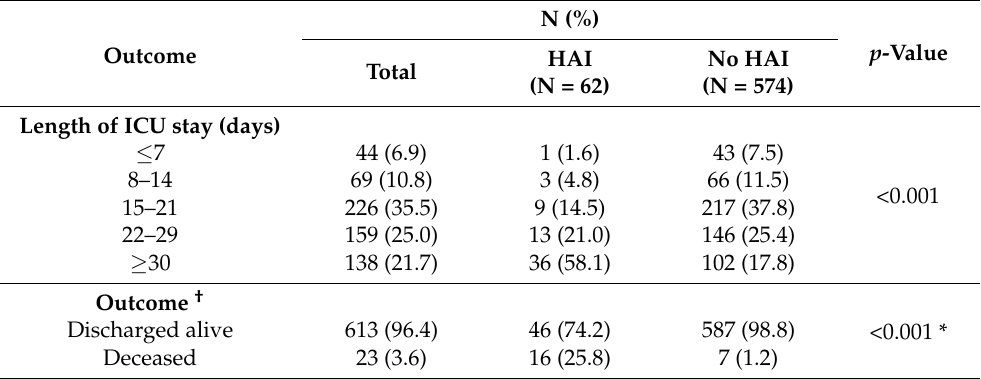
Table 3. Outcomes of COVID-19 patients with healthcare-associated infections (HAIs) in